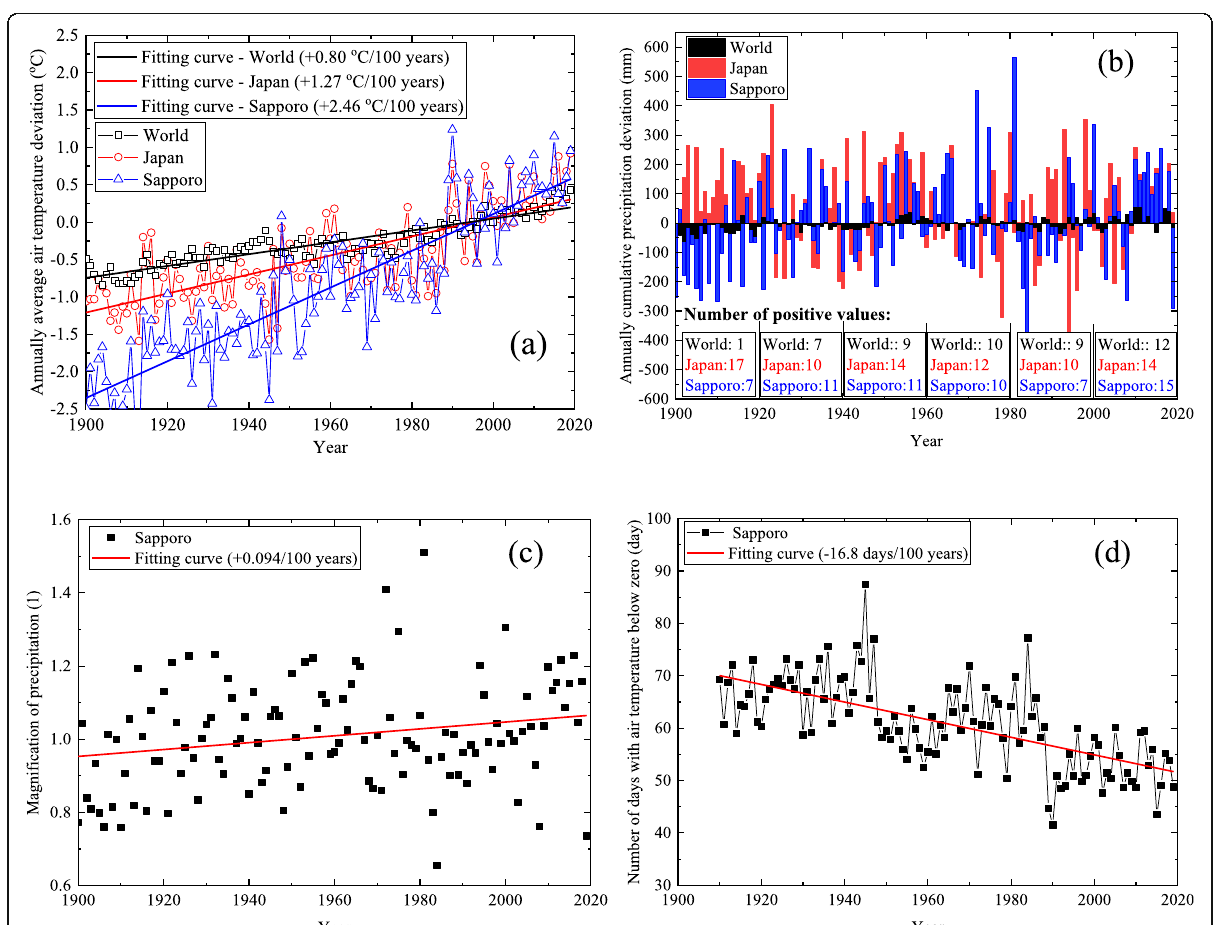
Fig. 2 Meteorological monitoring data of the world, Japan, and Sapporo referred from JMA. a . annually average air temperature deviation; ( b ) annually cumulative precipitation deviation; ( c ) magnification of precipitation, and ( d ) number of days with air temperature below